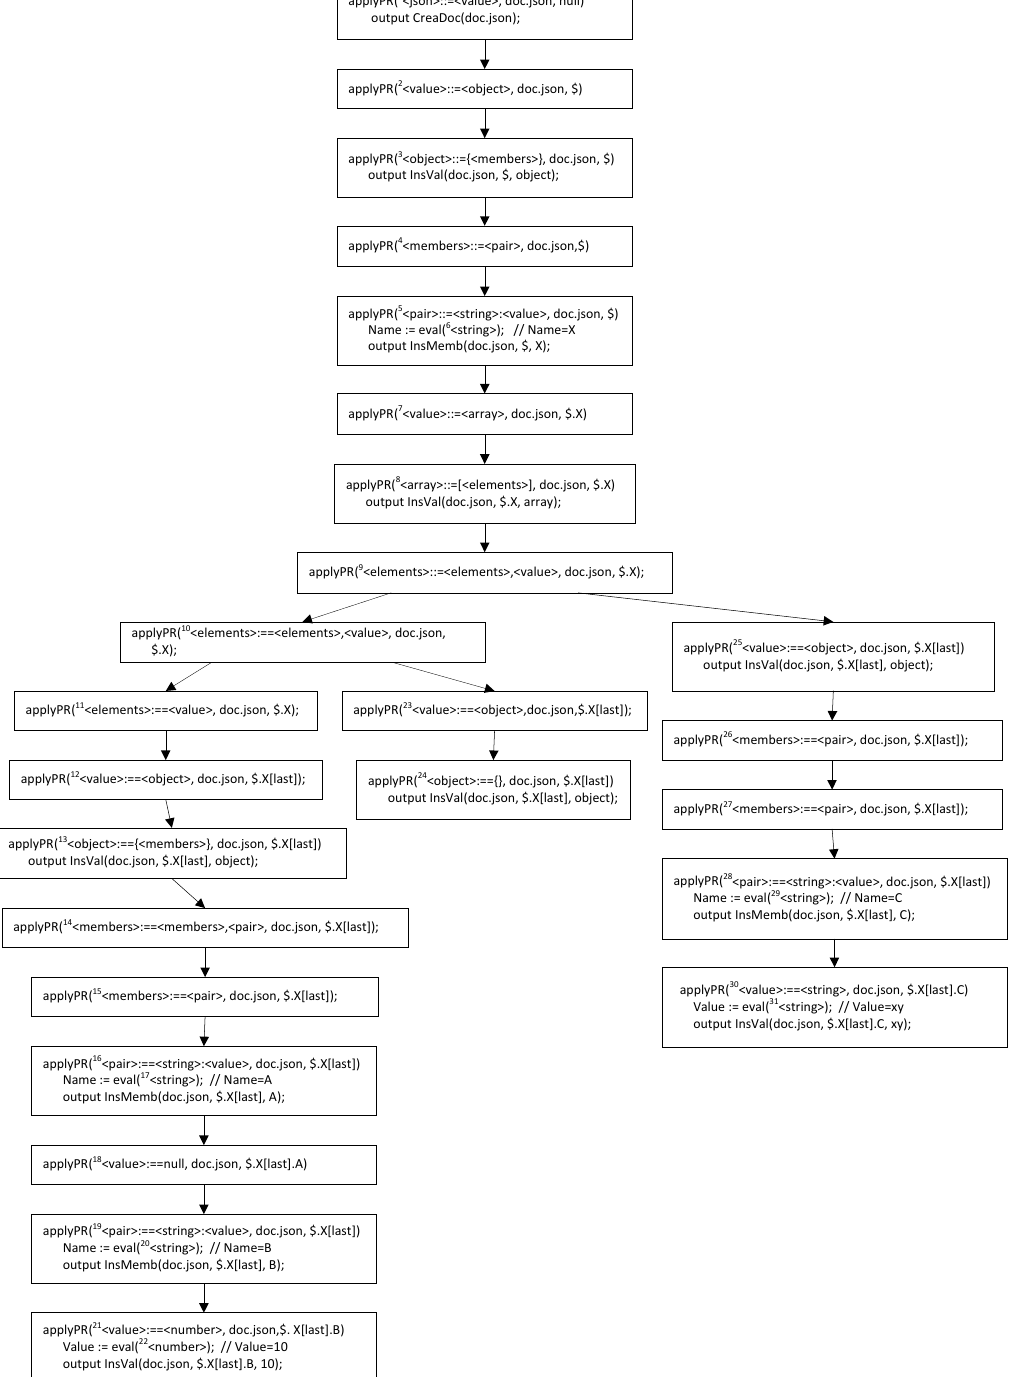
Figure A1. The execution trace of applyPR for the JSON instance (3) with syntax tree in Figure 5.